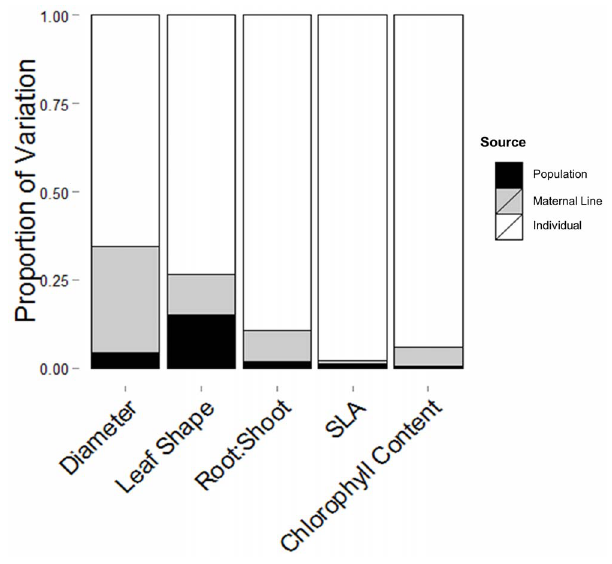
Figure 3. Proportion of total random effects variance ex- plained by population of origin, maternal line, and individual plant (residual) for five measured traits.